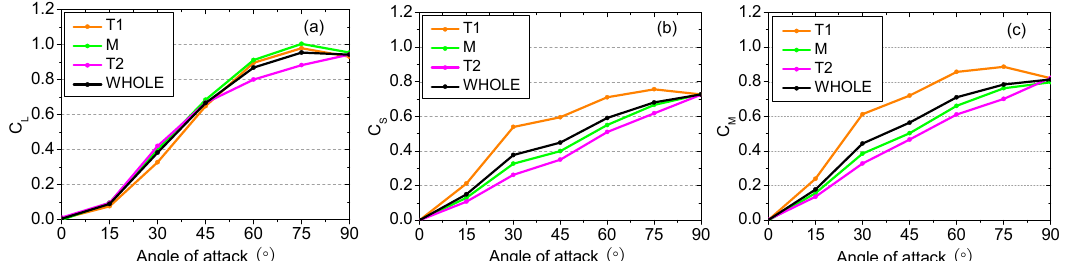
Figure 8. Aerodynamic force coefficients of rail vehicles versus angle of attack derived from Equation (9). ( a ) Aerodynamic lift force coefficient C L , ( b ) lateral (or side) aerodynamic force coefficient C S , ( c ) overturning moment coefficient C M ; for front ( T1 ), middle ( M ), and back ( T2 ) carriages, plus for the whole train (WHOLE).